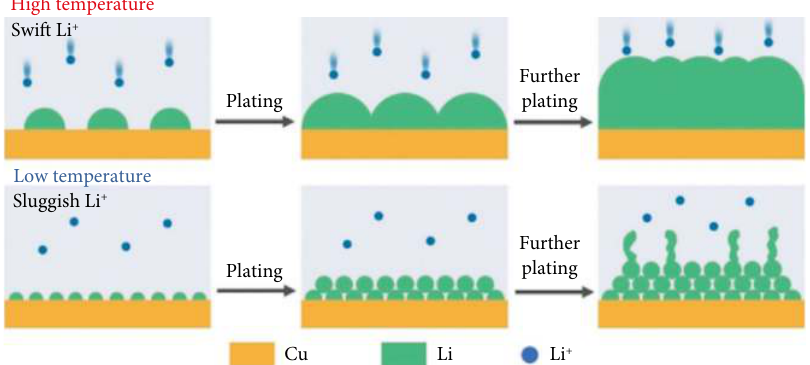
Fig. 1 Comparison of Li deposition behavior at different temperatures, indicating aggravated dendrite growth at low temperatures due to the sluggish diffu- sion kinetics of Li ions (reprinted with permission from Ref. [49], © 2019